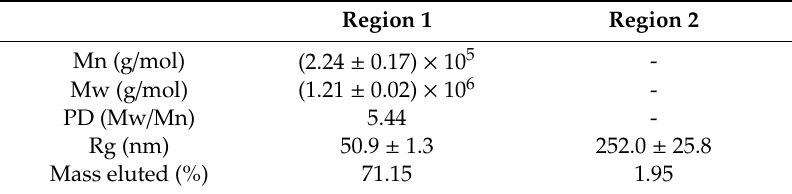
Table 1. Physico-chemical parameters of the mucin particles analysed by AF4.